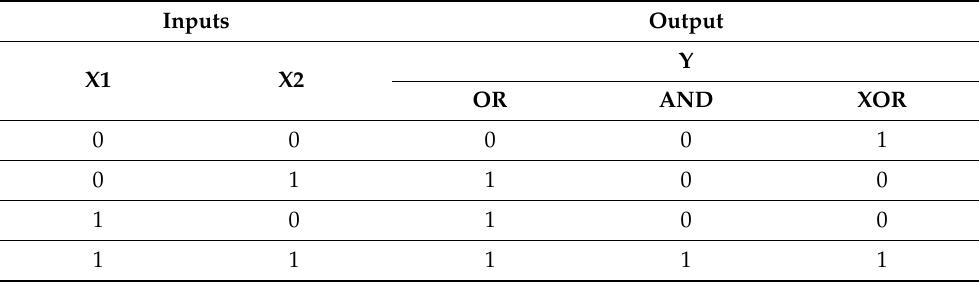
Table 1. The sets of discrete training